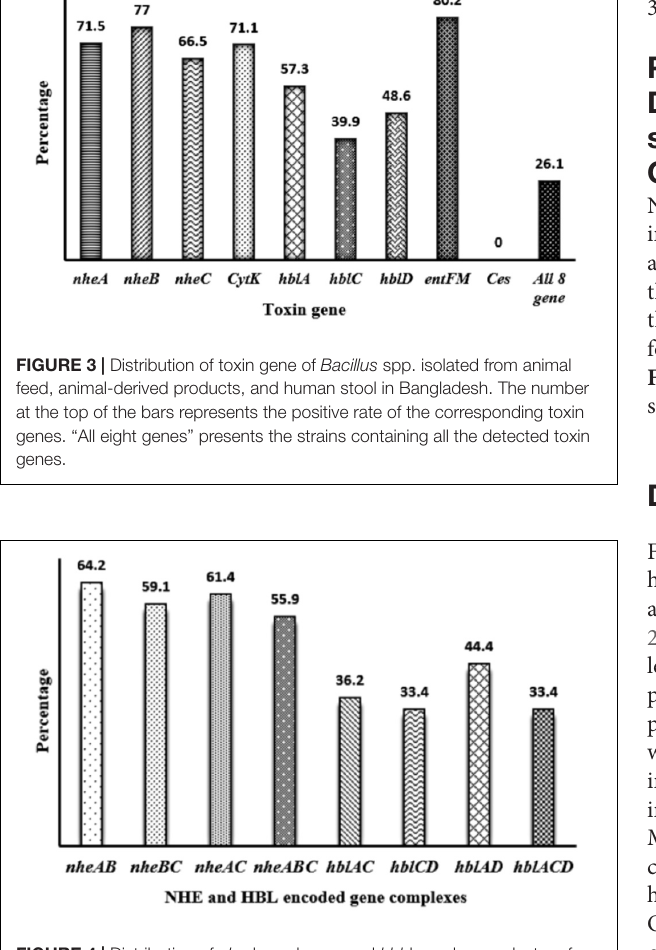
FIGURE 4 | Distribution of nhe -based gene and hbl -based gene cluster of Bacillus spp. isolated from animal feed, animal-derived products, and human stool in Bangladesh. The number at the top of the bars represents the positive rate of the corresponding toxin gene